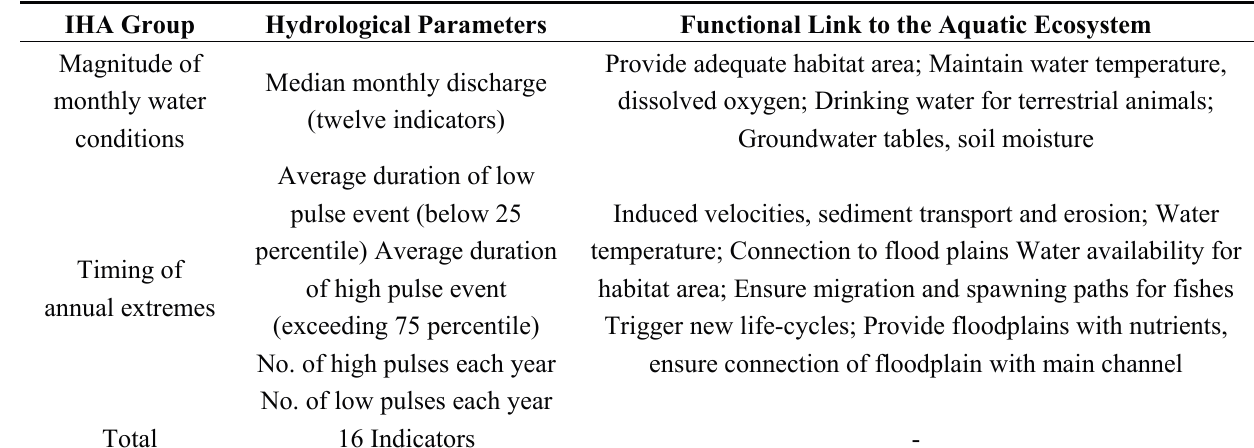
Table 1. List of selected IHA indicators and their functional link to aquatic ecosystem (Richter and Thomas